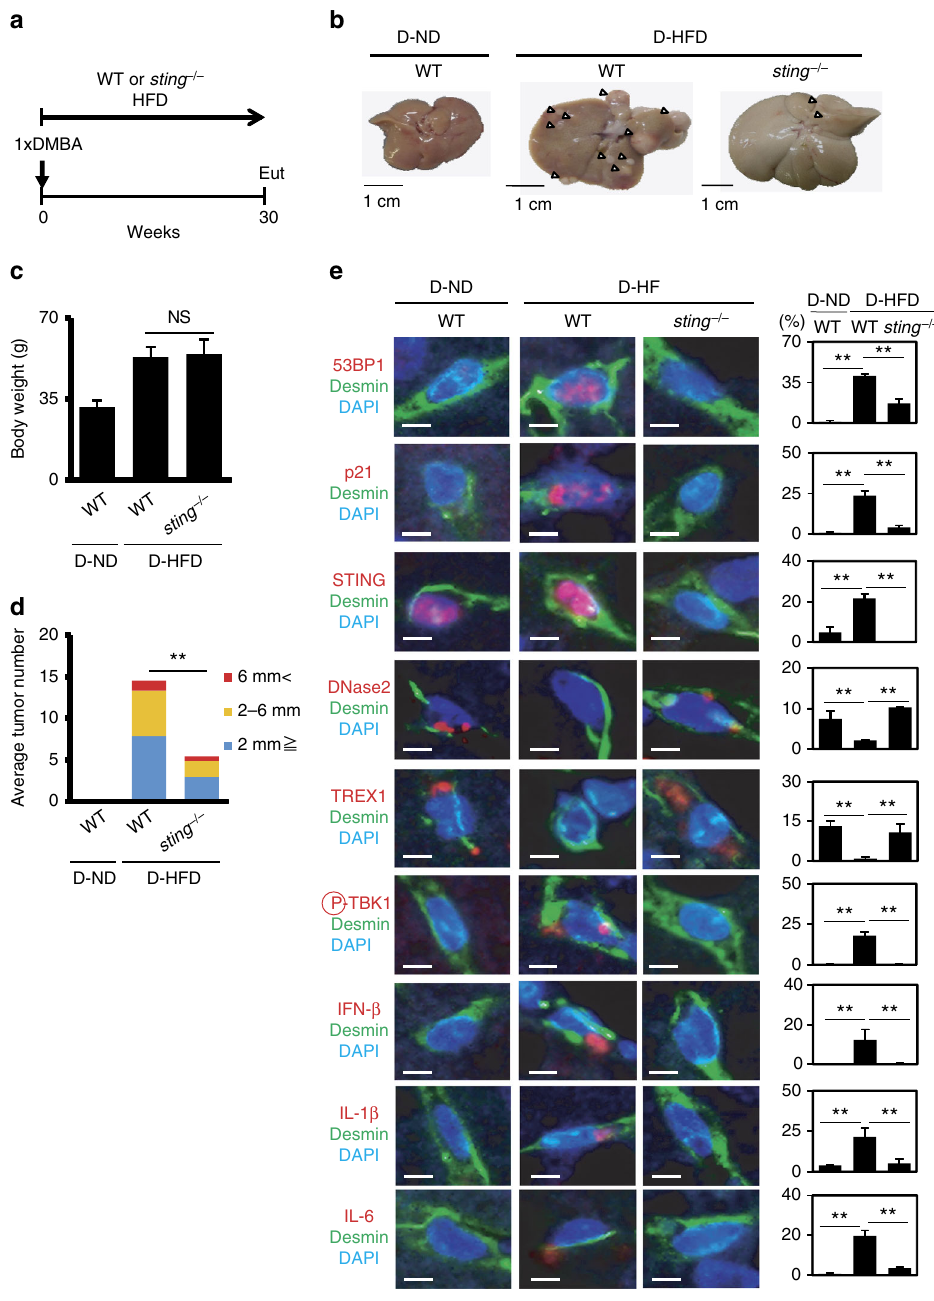
Fig. 6 Cytoplasmic DNA sensing pathway provokes SASP in HSCs. a Timeline of the experimental procedure (ND in WT, n = 27; HFD in WT, n = 24; HFD in sting − / − , n = 17). Eut, euthanasia. D, DMBA-treated. b Macroscopic photograph of livers of wild-type mice kept with ND (left), with HFD (middle) or sting − / − mice kept with HFD (right) for 30 weeks after the administration of DMBA. The arrowheads indicate HCCs. c The average body weight of each group at the age of 30 weeks. d The average liver tumor numbers and the relative size distribution (classi fi ed as >6, 2 – 6, ≤ 2 mm). e Immuno fl uorescence analysis of liver section. HSCs were visualized by Desmin staining (green) and the cell nuclei were stained by 4,6-diamidino-2-phenylindole (DAPI; blue). The histograms indicate the percentages of Desmin expressing cells that were positive for indicated markers. Scale bars, 25 μ m. Data of three to four individual mice in each group are represented as means± SD. More than 100 cells in total were counted for statistical analysis. NS, not signi fi cant. (** P < 0.01; one-way